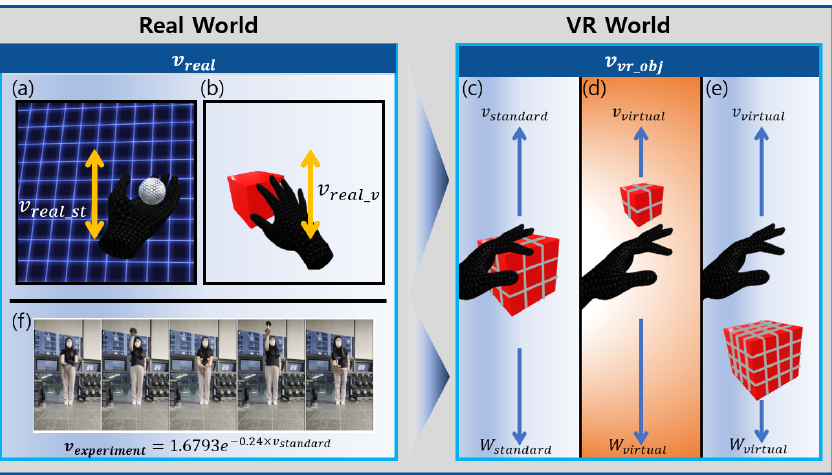
Figure 1. Based on the visual illusion effect, fundamental driving principles of pseudo-haptic customized virtual object weight algorithms. ( a ) the speed of lifting a golf ball existing in a real space, which refers to the y-axis movement speed of a 3D hand model ( v real _ st ), ( b ) the speed of a 3D hand model that lifts a virtual object other than the standard weight ( v real _ v ), and ( c ) the driving principle of an object with a standard weight. In order to recognize a user-customized weight, it is necessary to lift an object having the same weight existing in real space. The weight of an object with a standard weight is called (cid:87) standard and is based on the actual weight of the golf ball. The lifting speed of this object is called v standard , which is defined as the standard speed of raising the standard weight, so it can be considered to be the same as the speed v real _ st of the 3D hand model. In addition, Figre 1 also shows ( d , e ) a situation in which the weight of a virtual object is lighter or heavier than a golf ball having a standard weight, where (cid:87) virtual refers to the weight of a virtual object that has a different weight than the standard weight and v virtual refers to the speed at which a virtual object with a weight of (cid:87) virtual is lifted, which is the moving speed of the virtual object and not the speed of the 3D hand model, ( d ) that if the weight of the virtual object is lighter than (cid:87) standard , the virtual object is higher even if the object is lifted at a speed of v standard , ( e ) that if the weight of the virtual object is heavier than (cid:87) standard , the virtual object is lower even if the object is lifted at a speed of v standard , and ( f ) the equation according to the experiment of lifting an object according to a weight in real space ( v experiment ). An experiment was conducted in real space to set a natural offset threshold in a VR